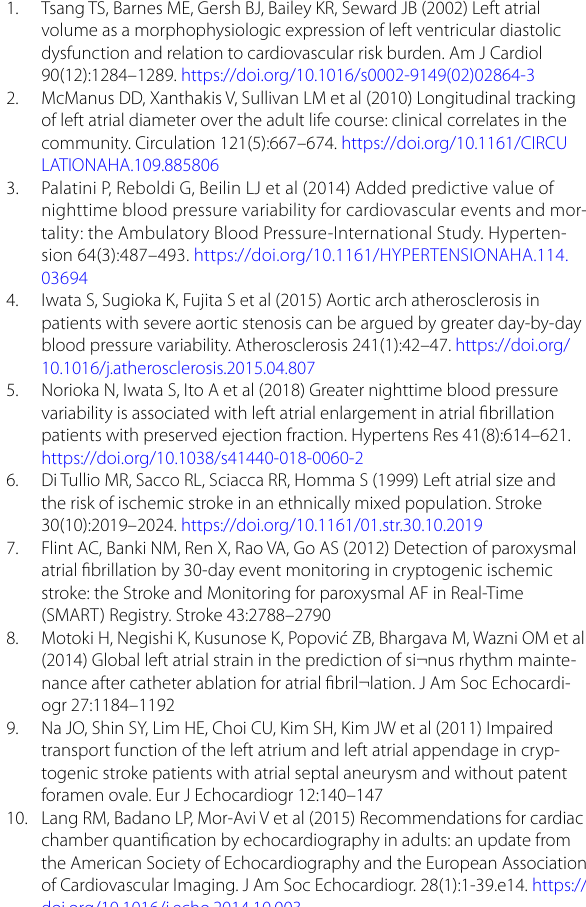
Min LAVI, minimum left atrial volume index; LA, left atrial; Max LAVI, maximum left atrial volume index; LA EF, left atrial ejection fraction; 24 H, 24 hours; CI, confidence interval; and OR, odds